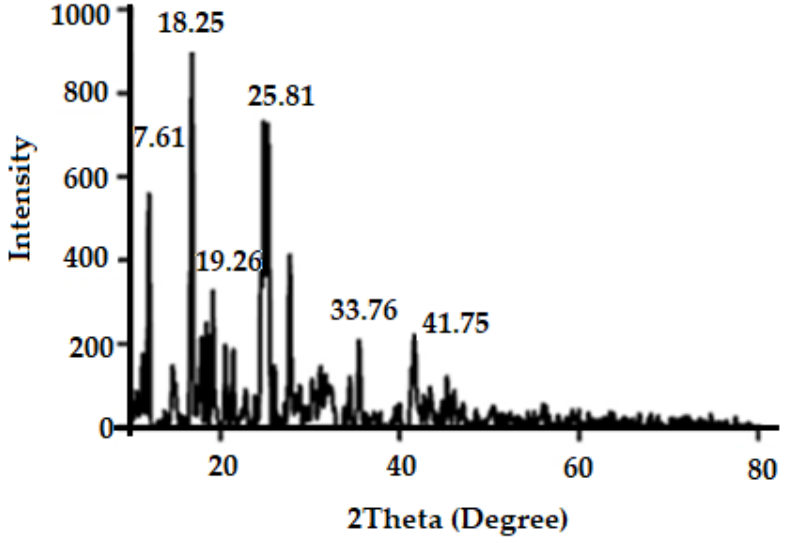
Figure 4. Powder X-ray diffraction pattern of Zn-MOFs.